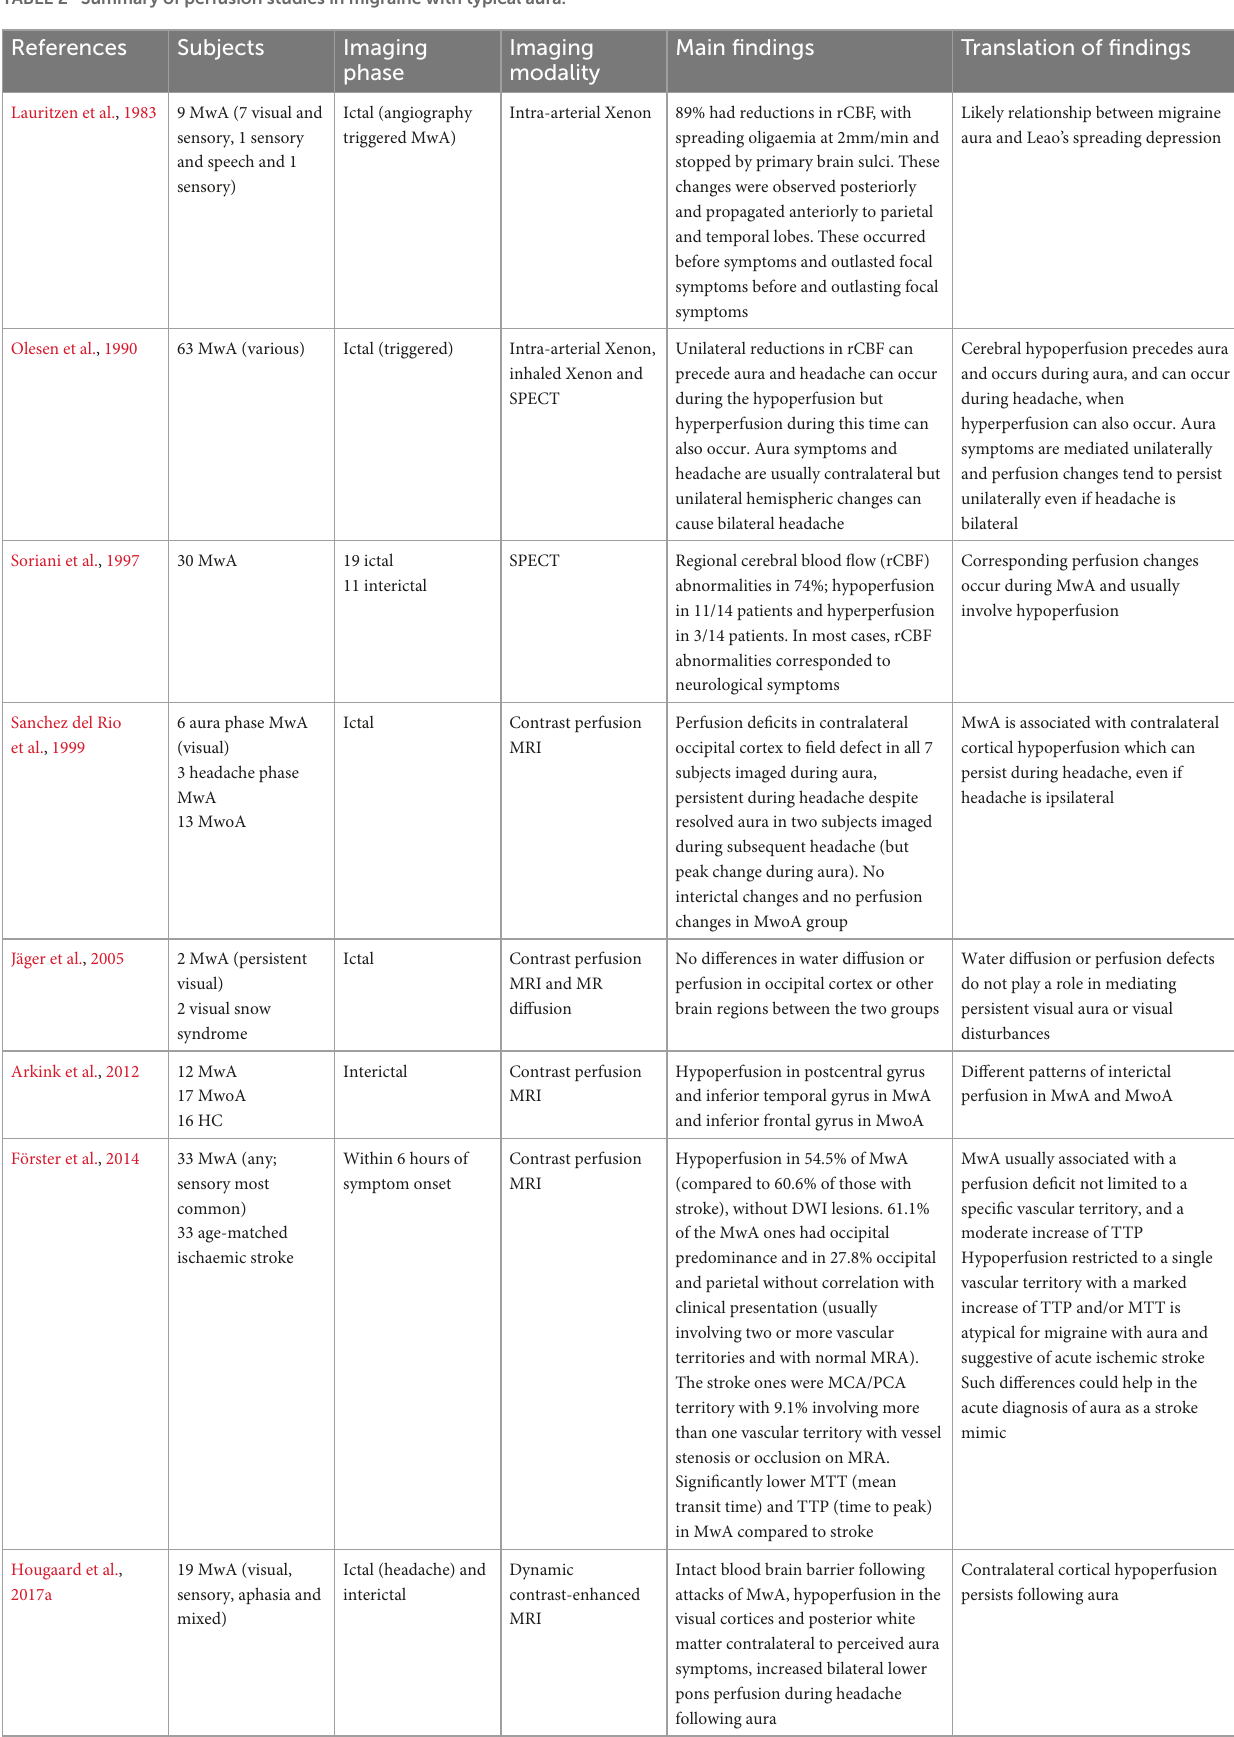
TABLE 2 Summary of perfusion studies in migraine with typical